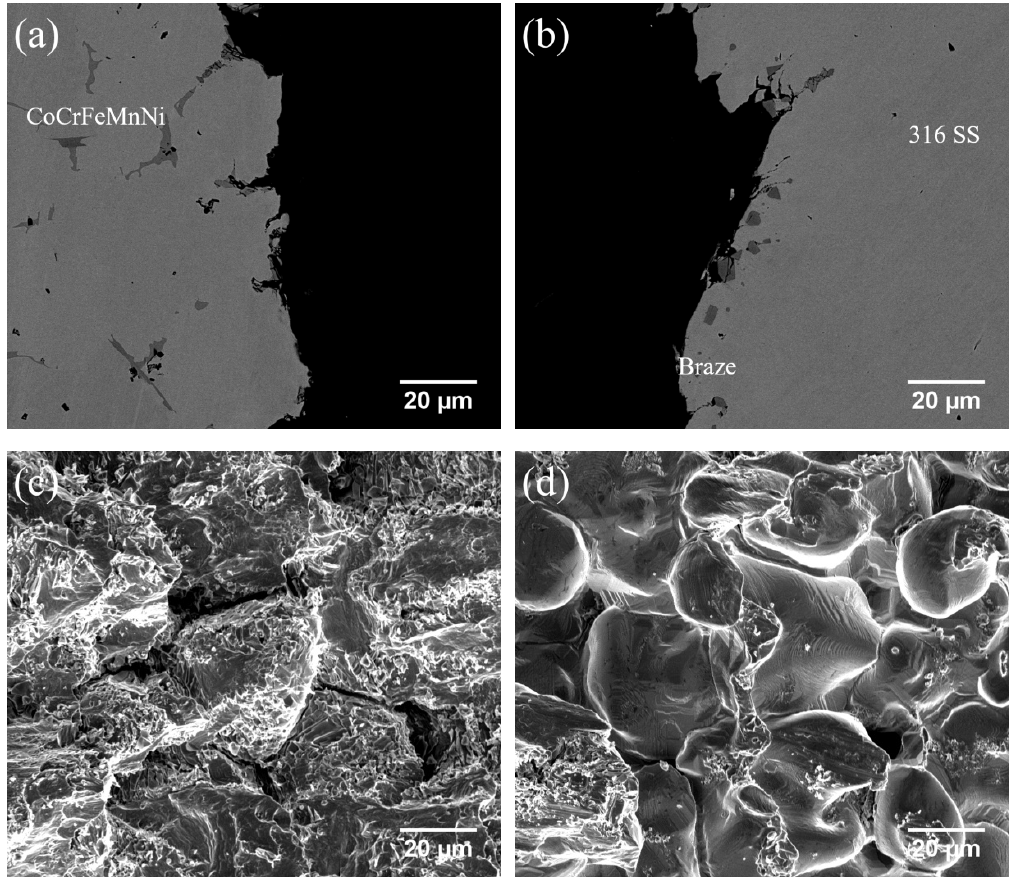
Figure 10. SEM ( a ) CoCrFeMnNi side, ( b ) 316 SS side BEI cross-sections, ( c , d ) SEI fractographs of CoCrFeMnNi/MBF601/316 SS joint infrared brazed at 1080 °C for 600 s.